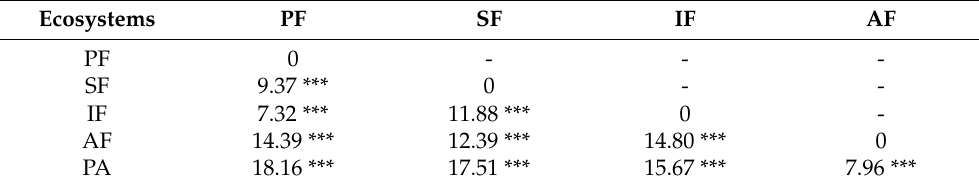
Table 2. PERMANOVA results (based on Bray–Curtis similarity) comparing the composition of high-level functionality (HLF) assemblages between the ecosystems (F = 38.14, p < 0.0001). Ecosystems PF SF IF AF PF 0 - - - SF 8.93 *** 0 - - IF 4.34 *** 9.78 *** 0 - AF 13.39 *** 9.88 *** 12.34 *** 0 PA 12.46 *** 15.21 *** 2.54 * 23.97